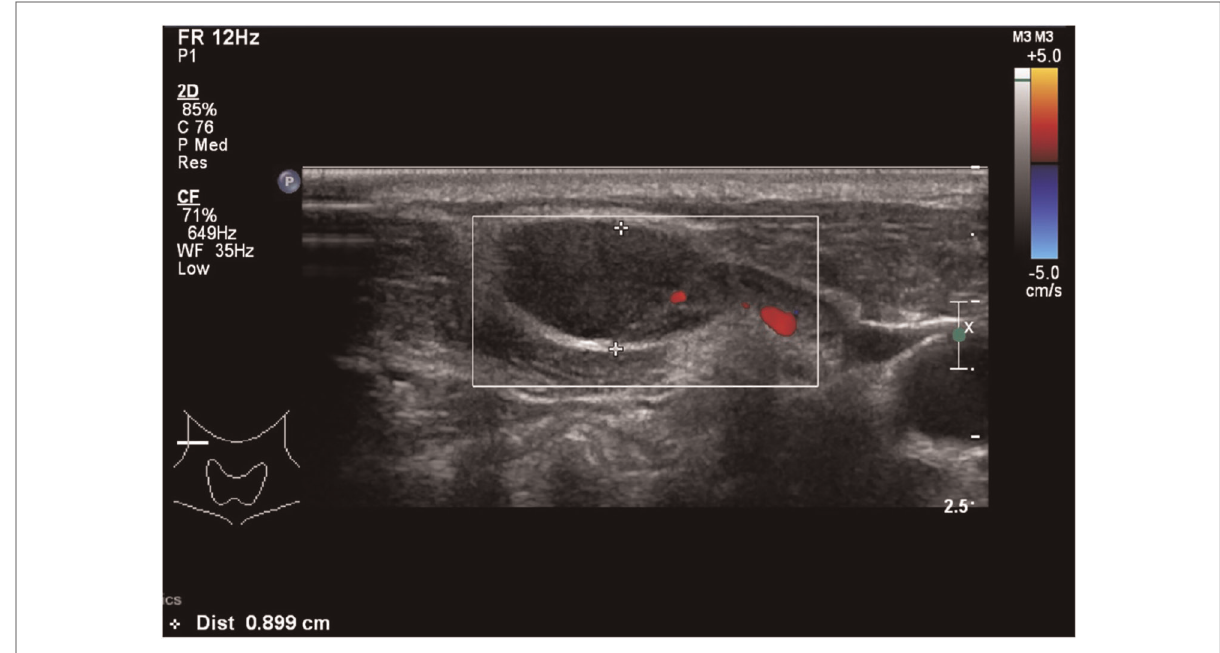
FIGURE 1 A neck ultrasound showing an enlarged lymph node which measures 1.9 cm in transverse diameter, 0.8 cm in anteroposterior diameter and 2.2 cm in crania-caudal diameter in the right upper posterior triangle